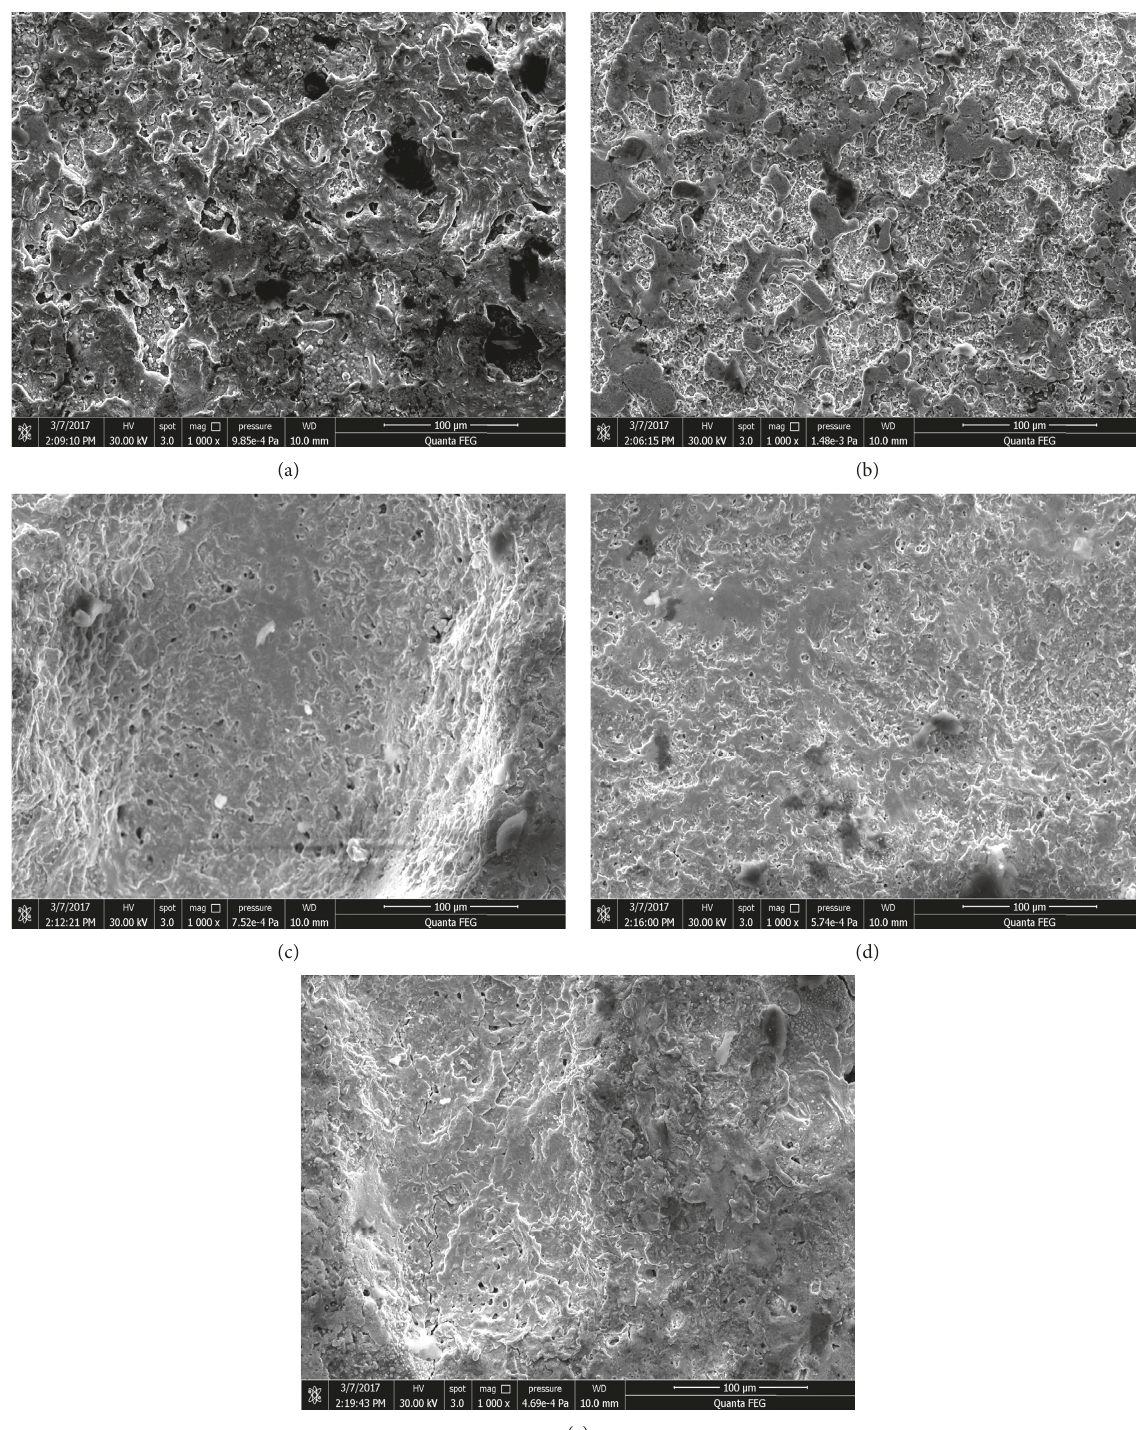
Figure 9: The surface microstructure photos of Ag-SnO 2 /Fe 2 O 3 contact material with different additive particle sizes: (a) 50nm, (b) 200nm, (c) 500nm, (d) 1000nm, and (e)